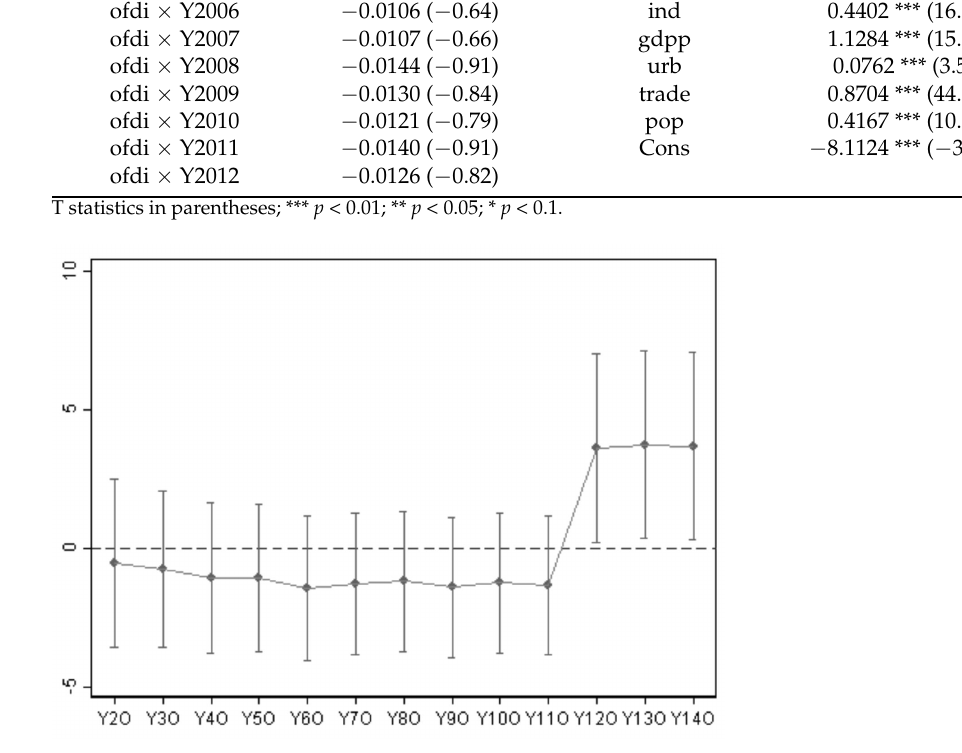
Figure 3. Changes in the impact of China’s